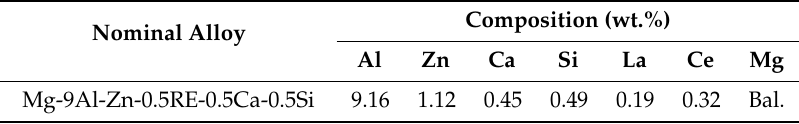
Table 1. Chemical component analysis of the as-cast AZXSE91000 alloy.